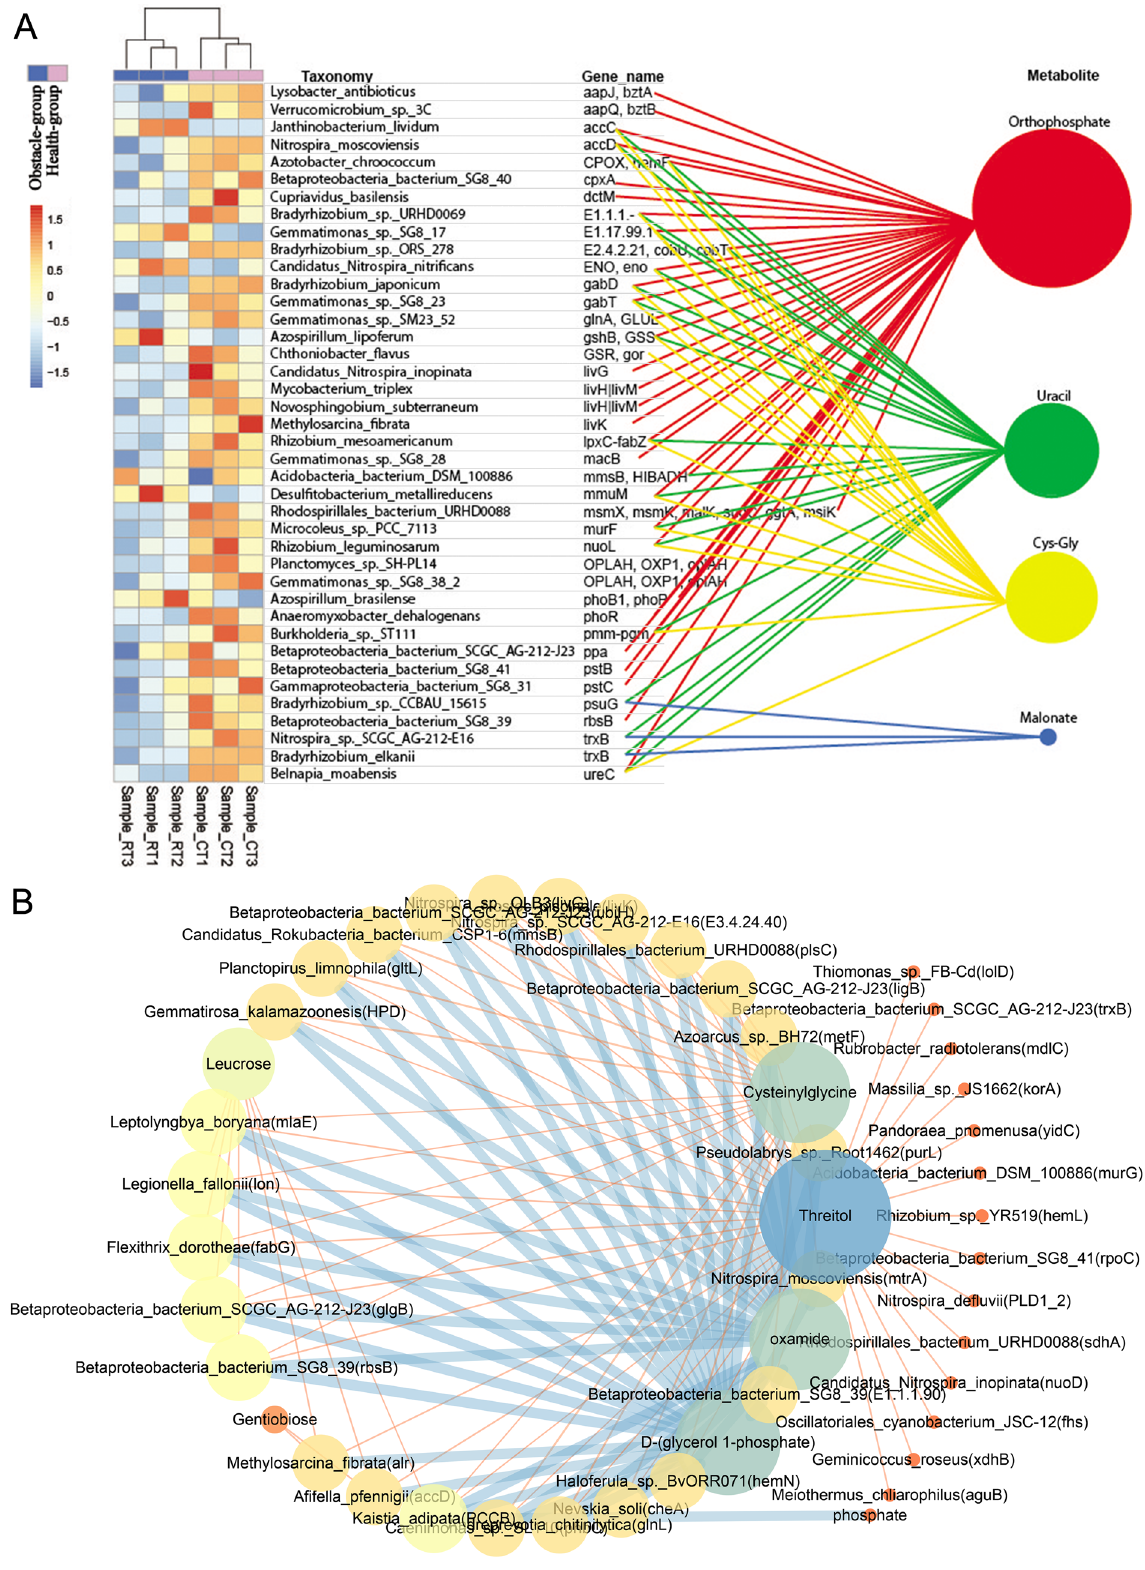
Figure 6. The integrated analysis of different bacteria, metabolites and bacterial genes. ( A ) The relationship between different metabolites and different genes enriched in the same pathway. The heatmap shows the relative abundance of bacteria in different groups, the redder the color, the higher the abundance. The colored scale shows the level of abundance based on the standardized relative abundances data. Gene name and bacterial name horizontally correspond to each other, the larger the size, the higher the interaction. ( B ) The interacting network among the top 50 metabolites and genes, the darker and bigger the node, the richer the interaction with the